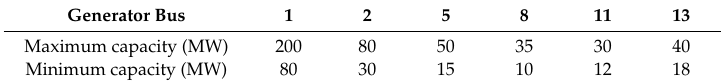
Table 1. Parameters of the thermal generators.